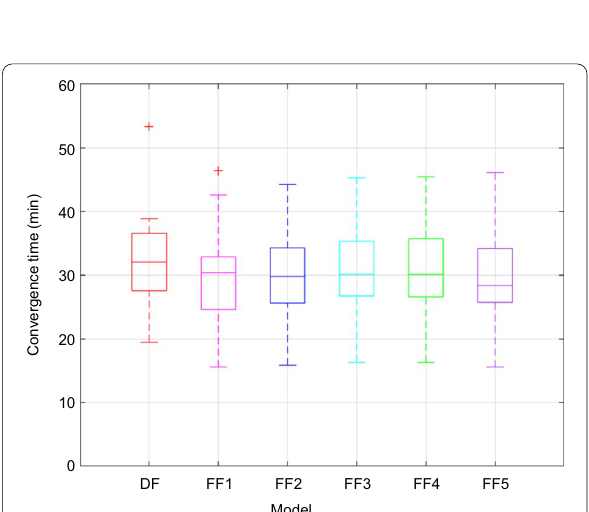
Fig. 11 Estimated ZTD delay time series at station pots with